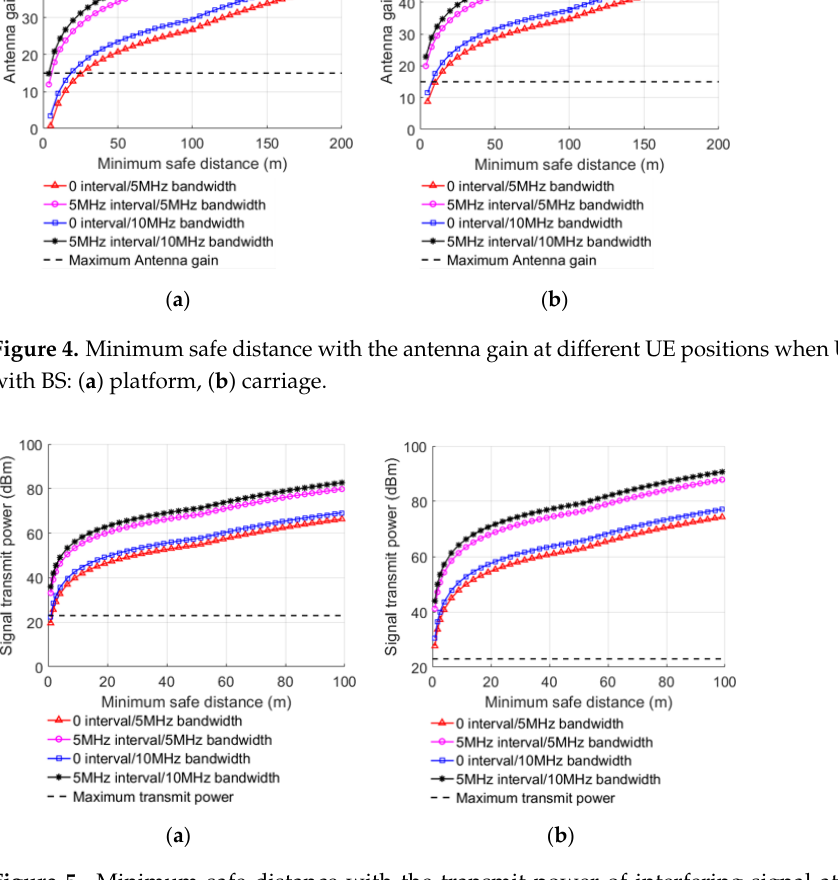
Figure 5. Minimum safe distance with the transmit power of interfering signal at different UE positions when UE interfering with TE: ( a ) platform, ( b ) carriage.